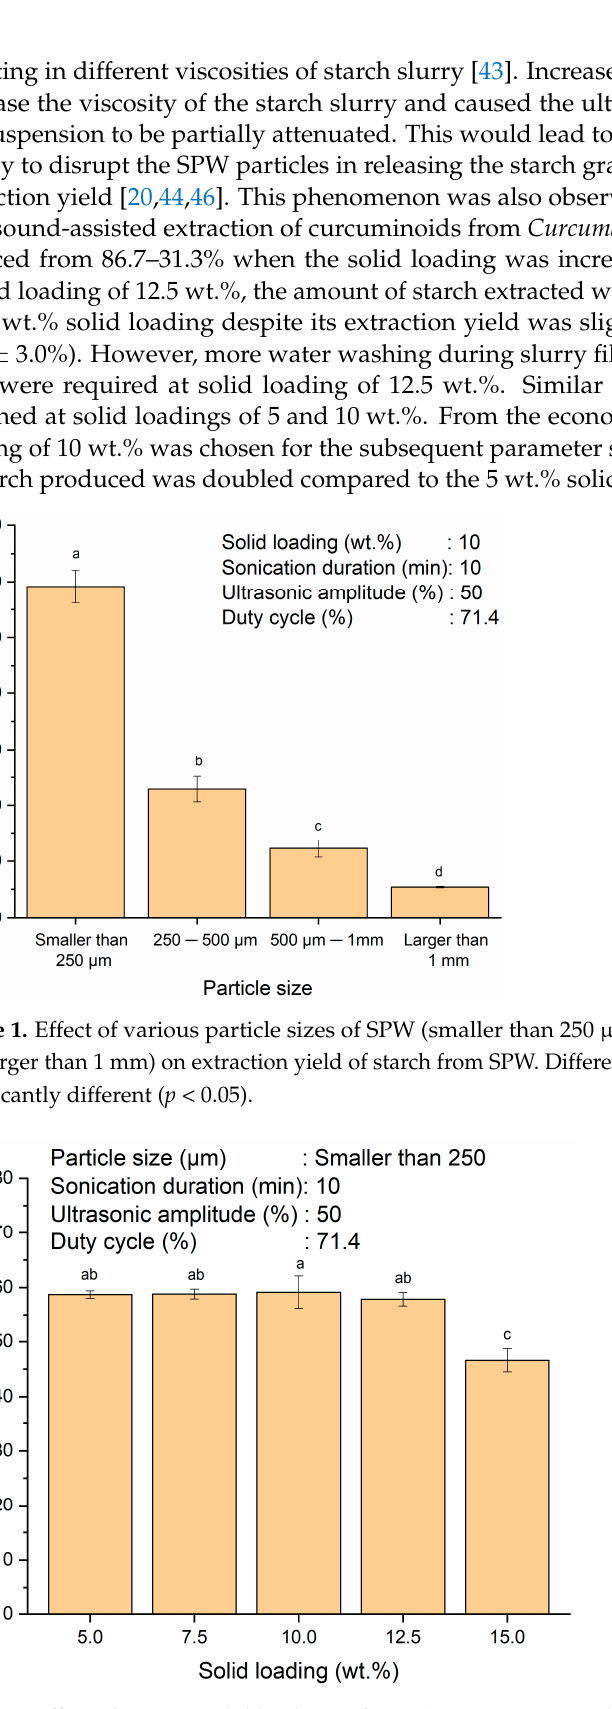
Figure 2. Effect of various solid loadings of SPW (5, 7.5, 10, 12.5 and 15 wt.%) on extraction yield of starch from SPW. Different letters indicate the values are significantly different ( p < 0.05).